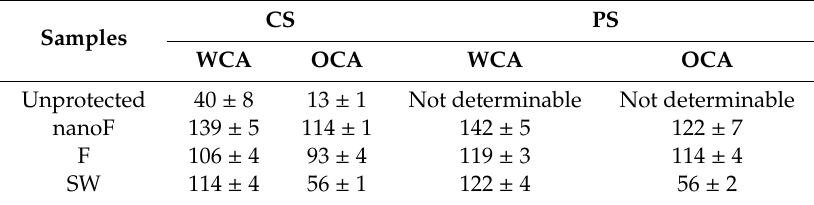
Table 2. Water-stone static contact angle (WCA) and oil-stone static contact angle (OCA), both in degrees, measured on unprotected and protected PS and CS stone surfaces, with the indication of standard deviation.